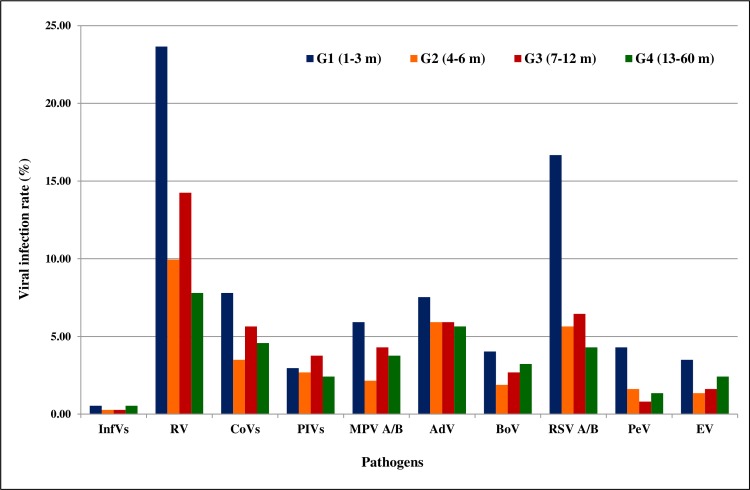
Distribution of viral infection rates in relation to the age of patients.Four age groups are defined: G1 (1–3 m, blue), G2 (4–6 m, orange), G3 (7–12 m, red), and G4 (13–60 m, green). The rates of viral infection are represented in the y-axis, and the x-axis is described by tested viruses.